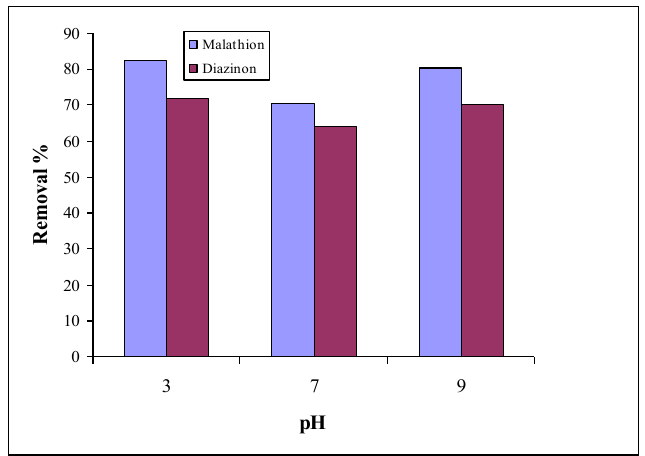
Figure 5 . Pesticide degrardation percentages at different pH after treatment with UV/H